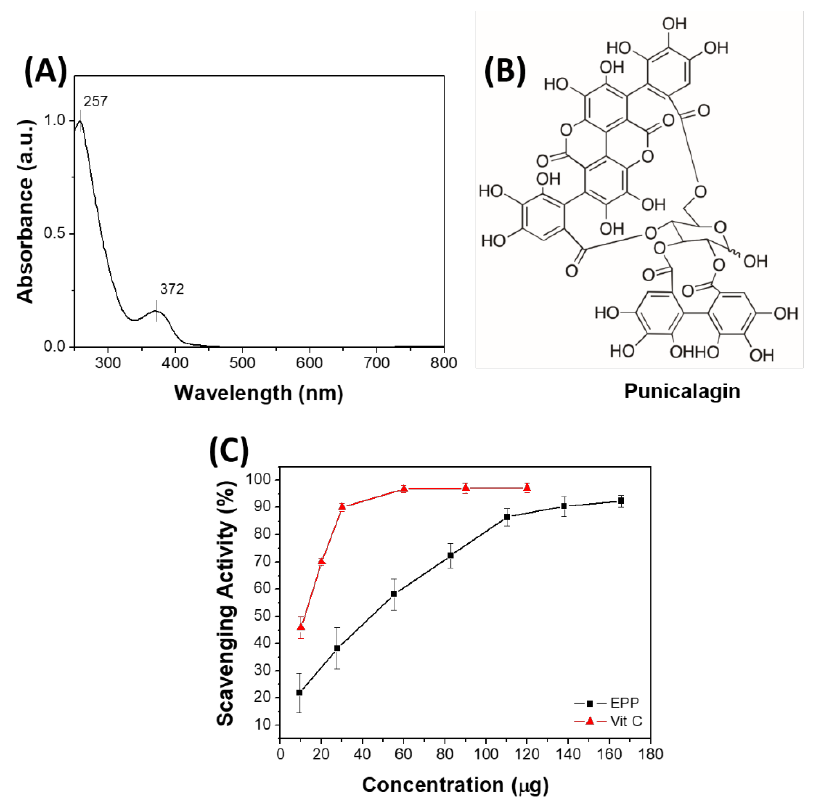
Figure 1. ( A ) UV–Vis spectrum of EPP; ( B ) molecular structure of punicalagin; ( C ) radical scavenging activity of EPP compared to that of vitamin C.